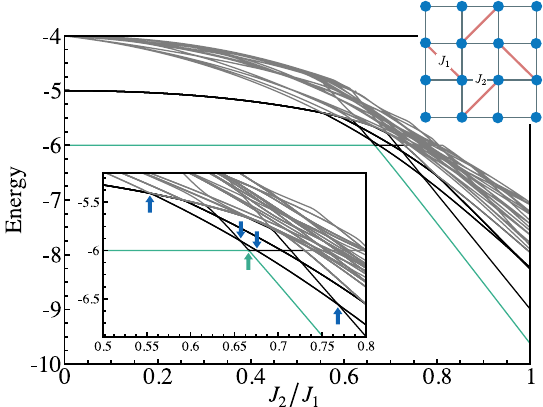
Fig. 7 Exact diagonalization results for the Shastry-Sutherland model. Upper right inset: schematic representation of the Shastry- Sutherland model 16-spin supercell used in this work. Main plot and the inner inset: low-energy part of its spectrum as a function of the inter-dimer exchange interaction J 2 / J 1 . Arrows denote transitions between quantum states. The green line represents the ground